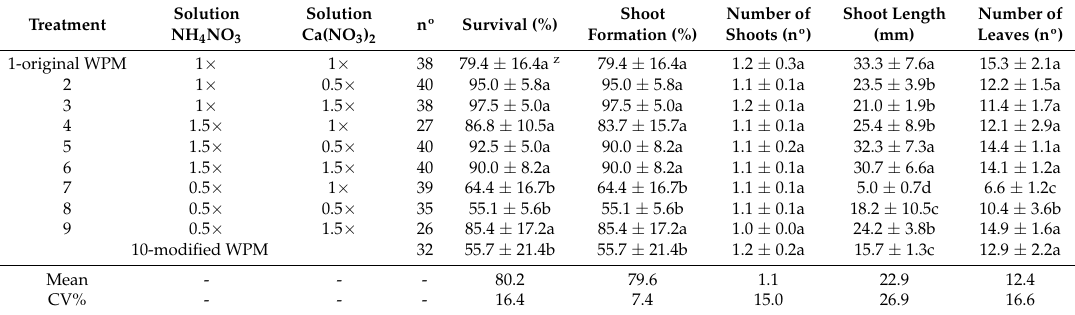
Table 6. Experiment 3 with treatments 1 to 9 on Woody Plant Medium (WPM) [18] with different ranges of NH 4 NO 3 (x) and Ca(NO 3 ) 2 · 4H 2 O (x) and treatment 10 on modified WPM [15], showing number of explants evaluated (nº), survival rate (%), shoot formation (%), number of shoots (nº), shoot length (mm), and number of leaves (nº) in ‘Delite’ rabbiteye blueberry in vitro establishment. Abbreviations: CV, coefficient of variation; nº,